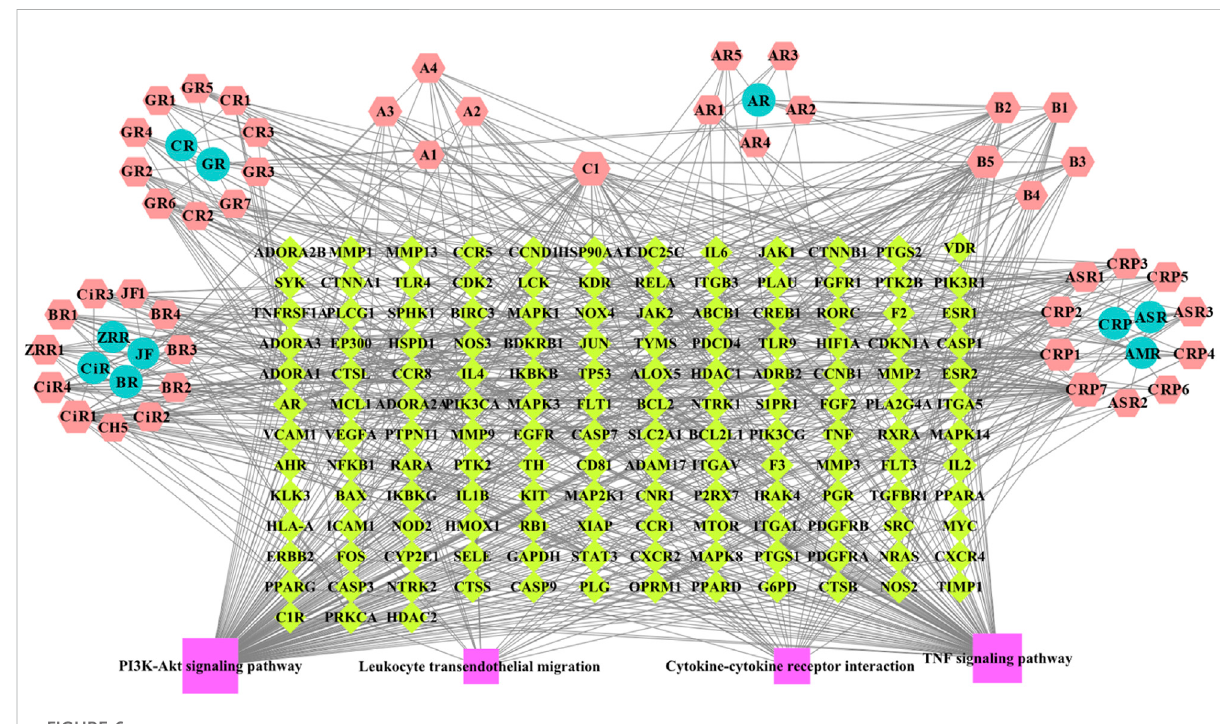
FIGURE 6 BZYQT-related “ compound-target-pathway ” network (hexagons mean potential bioactive components of BZYQT; circles mean composed herbal medicines of BZYQT; rhombuses mean immune-related targets and pulmonary in fl ammation-related targets; squares mean core signaling